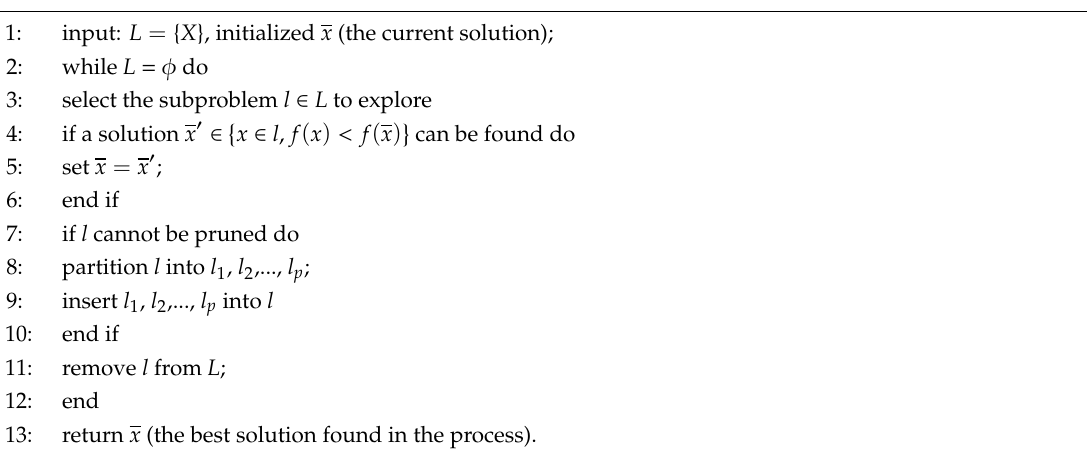
The Pseudocode of Branch and